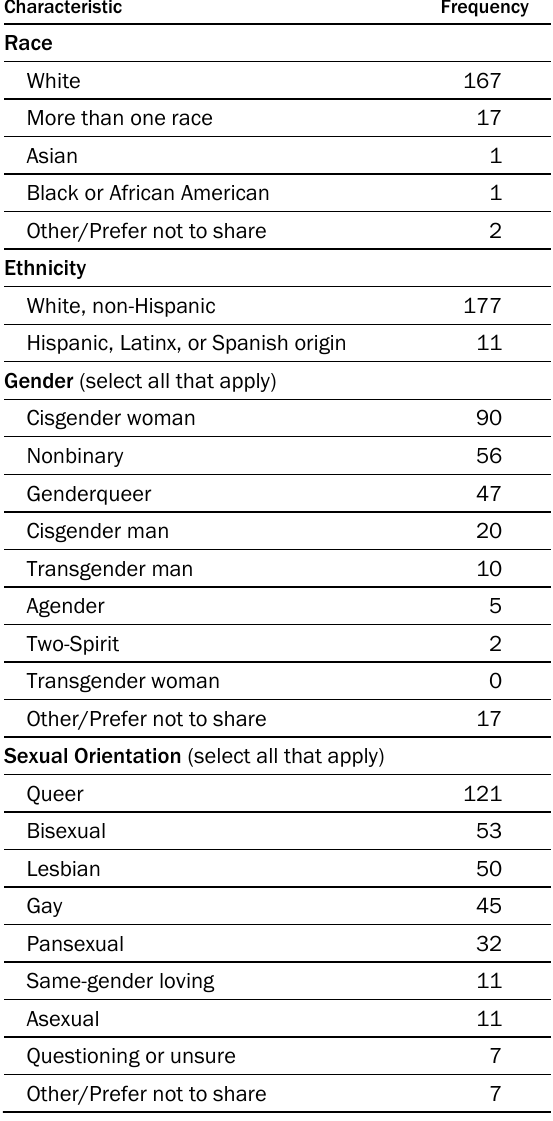
Table 1. Demographic Characteristics of the